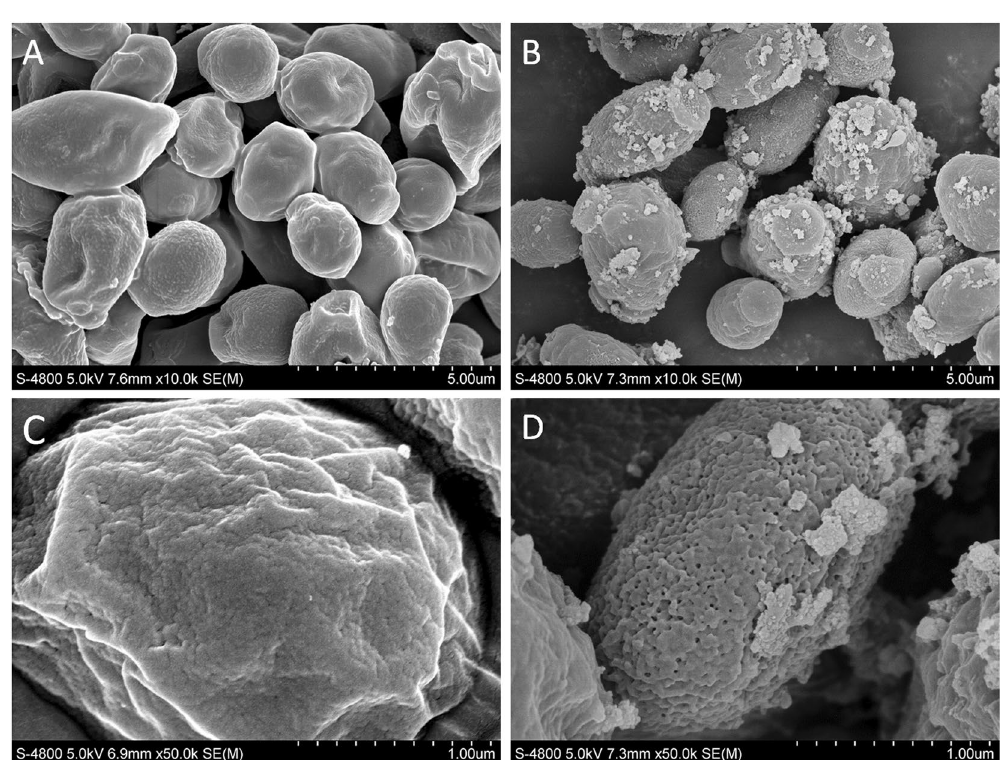
Figure 5. Fe-SEM images of C. albicans ATCC90028 morphology after incubation for 24 h. ( A , C ) Normal morphology of C. albicans ATCC90028. ( B , D ) Morphology of C. albicans ATCC90028 after incubation with AgBr/NPVP suspensions (1 × MFC) for 24